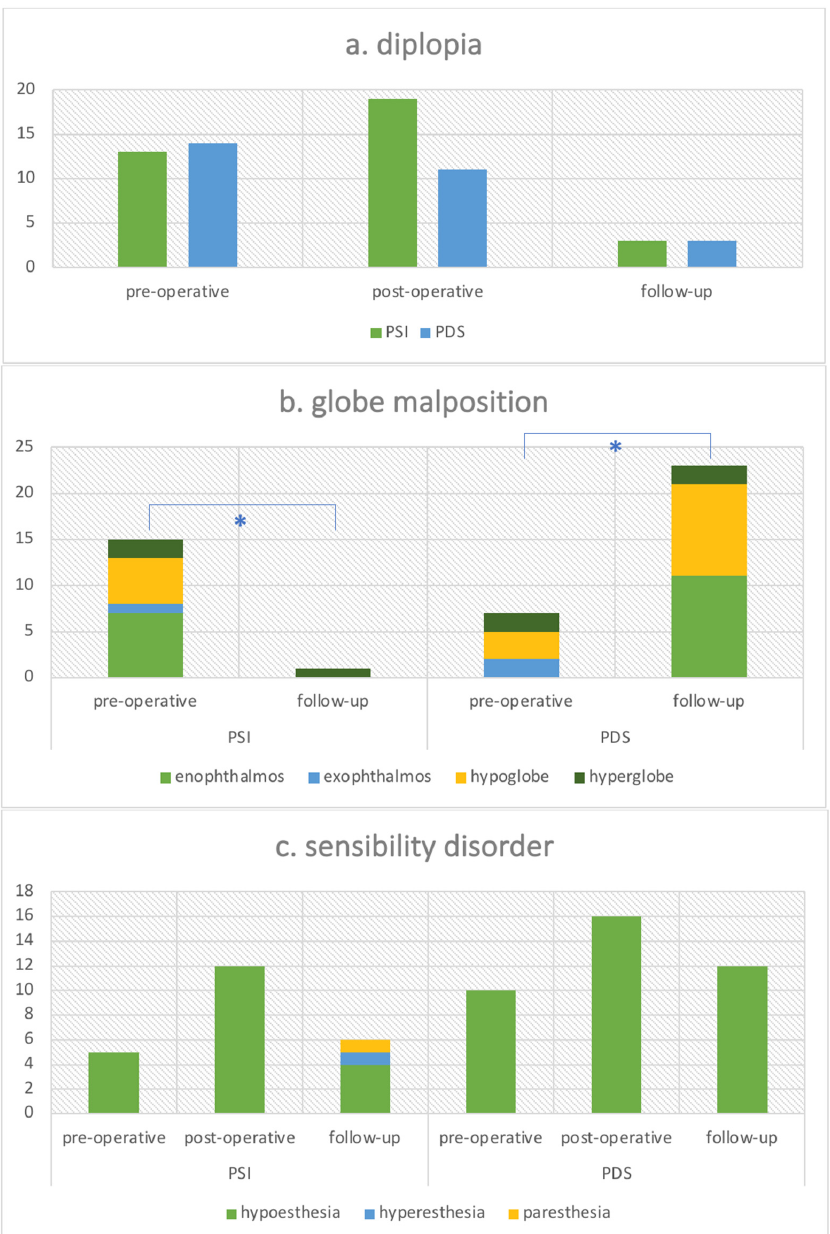
Figure 6. Clinical signs in two-wall orbital fracture. ( a ) Number of cases of diplopia pre-operative, post-operative and in the follow-up for the different study groups “PSI” versus “PDS”. ( b ) Number of cases of malposition of the globe including enophthalmos, exophthalmos, hypoglobe and hyperglobe pre-operative and in the follow-up for the different study groups “PSI” versus “PDS”. * indicates significance with p < 0.05. ( c ) Number of cases of sensibility disorders including hypoesthesia, hyperesthesia and paresthesia pre-operative, post-operative and in the follow-up for the different study groups “PSI” versus “PDS”.